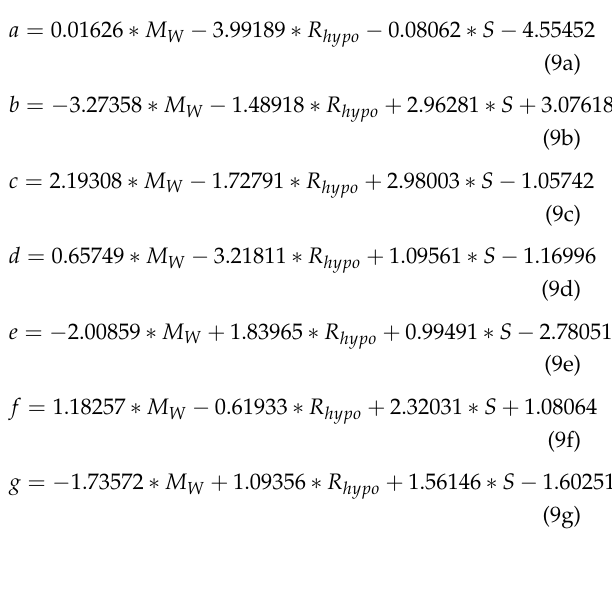
created by inserting the weights and biases indicated from Table 2 into Eq. (7). The expressions indicated in Eqs. (9) to (11) are utilized to determine the normalized value of log-scaled significant duration utilizing the input variables.